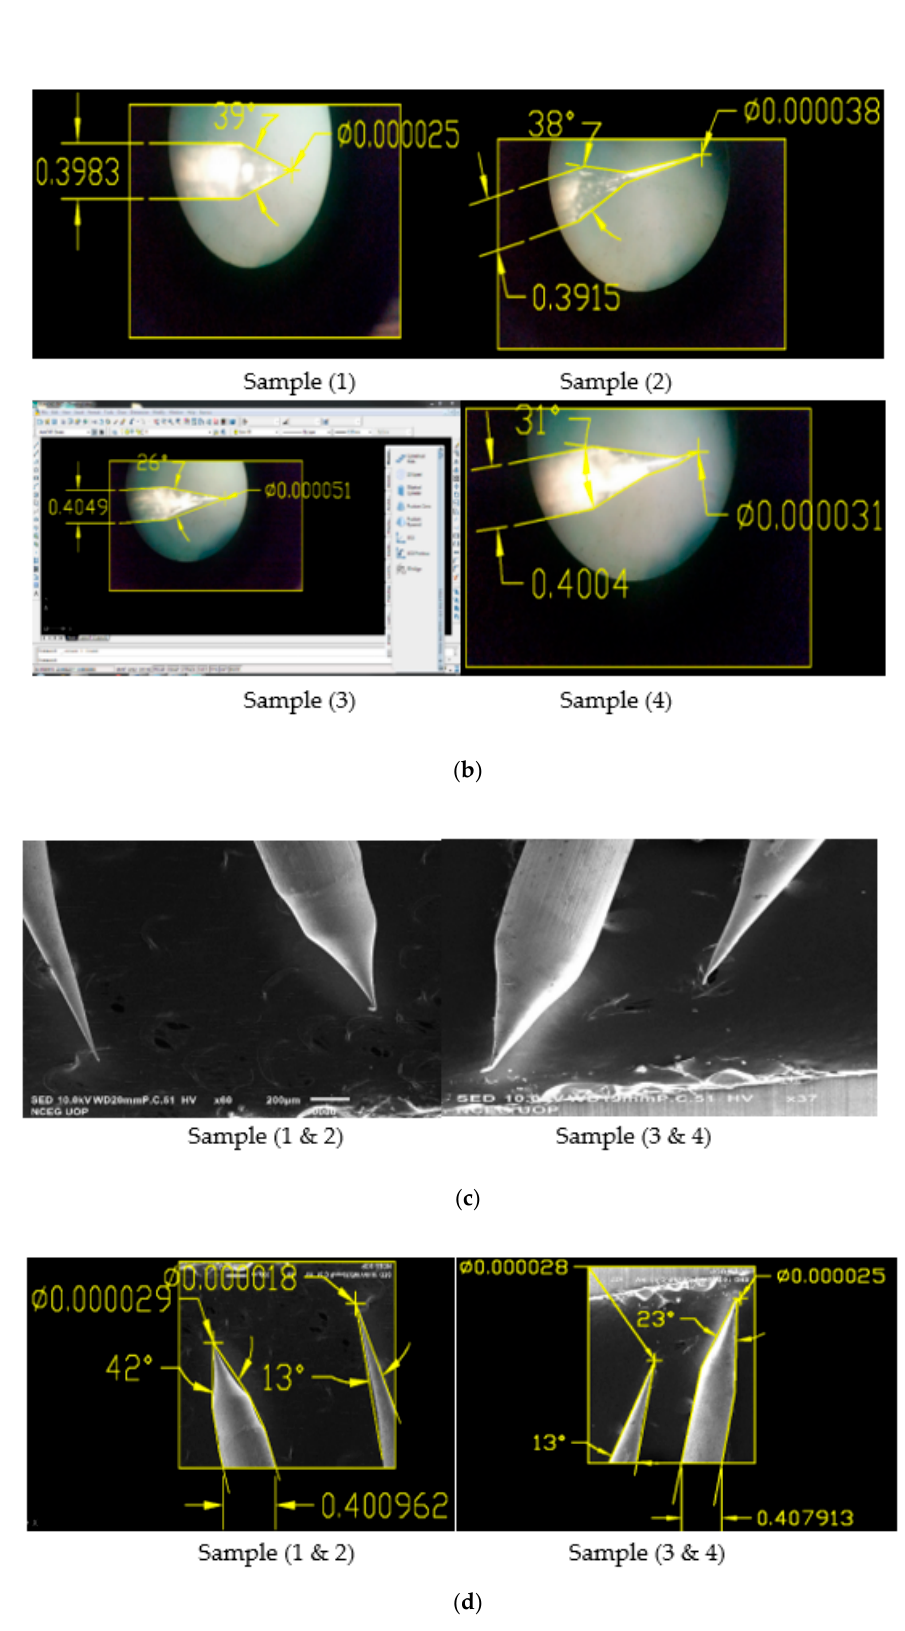
Figure 7. ( a ) OM Images of 0.4 mm tungsten tips prepared on DC etching in 2 Molar NaOH solution (16 g/200 mL); ( b ) OM Images of 0.4 mm tungsten tips showing cone angle and tip diameter measured using AutoCAD Software; ( c ) SEM Images of 0.4 mm tungsten tips prepared on DC etching in 4 Molar NaOH solution (32 g/200 mL); ( d ) SEM Images of 0.4 mm tungsten tips showing cone angle and tip diameter measured using AutoCAD